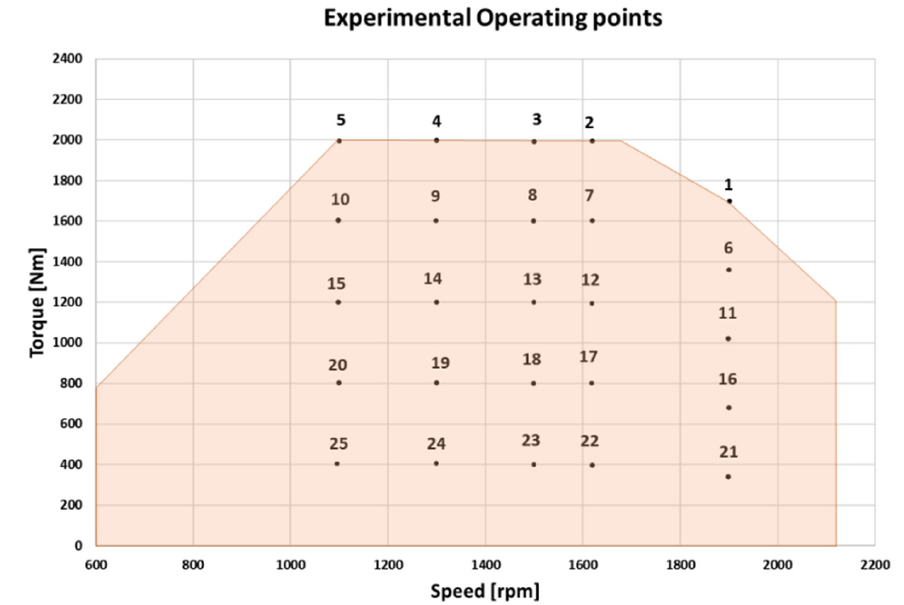
Figure 6. 25 Experimental engine operating conditions in the entire engine work plan.